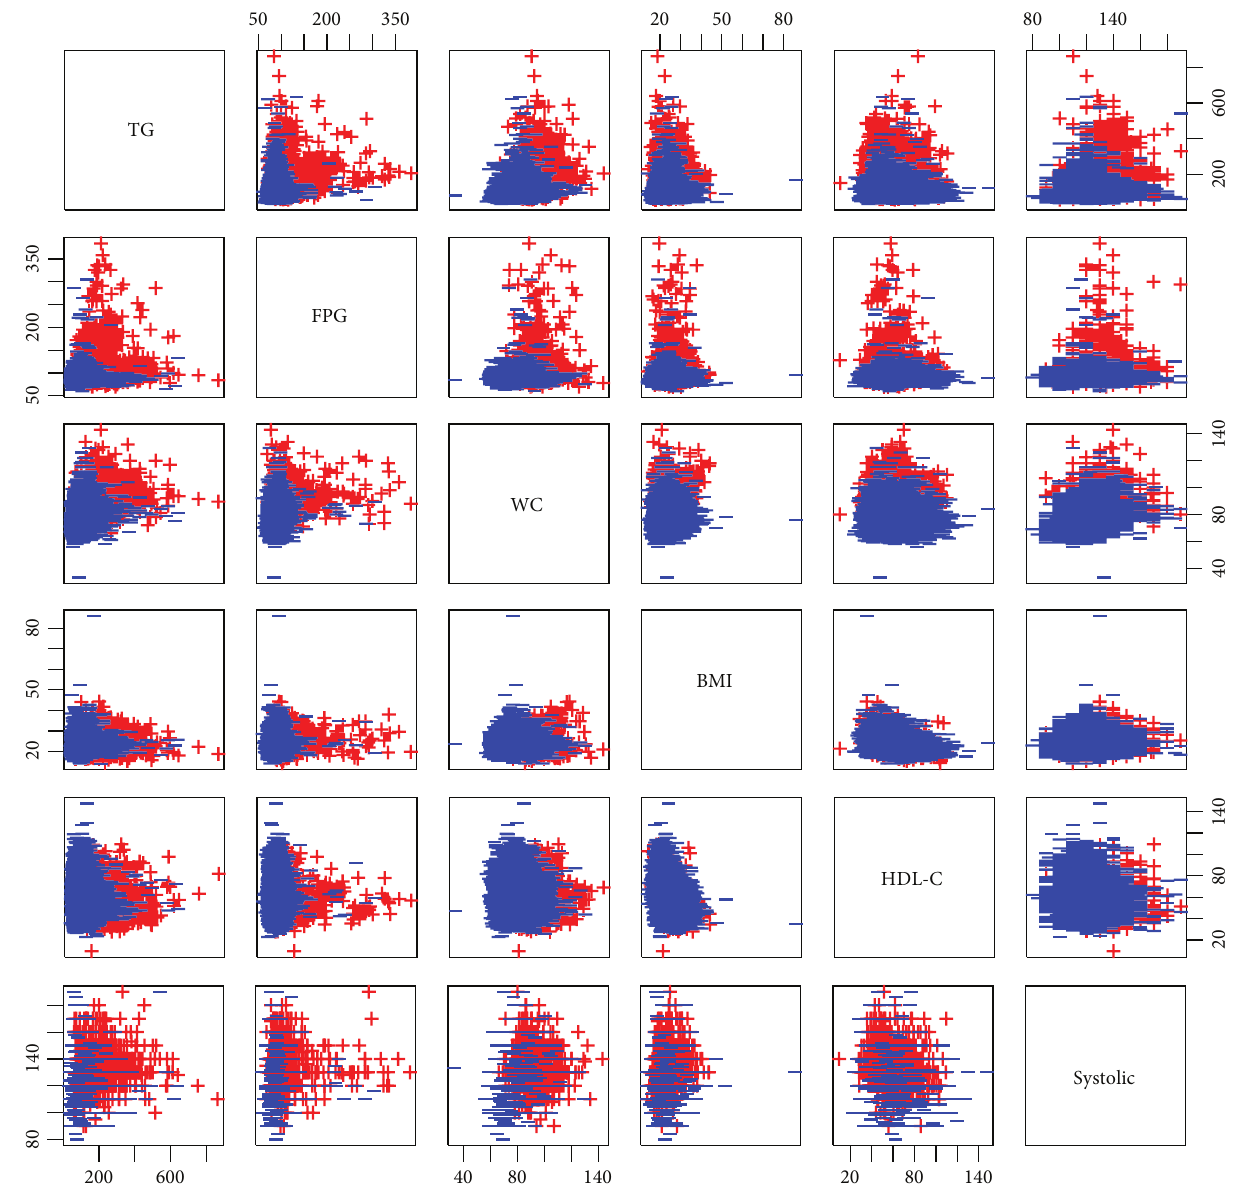
Figure 6: Scatter plots of MS component classifications: MS (red) and non-MS (blue)